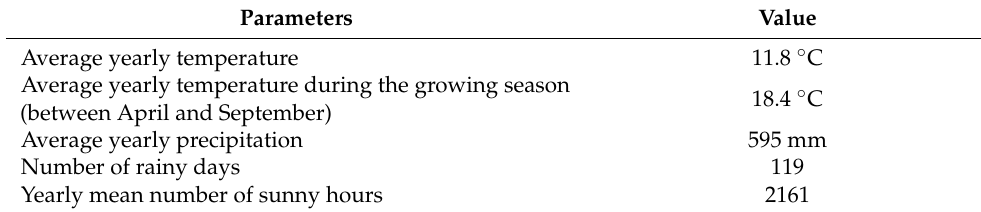
Table 1. Meteorological data during the data collection 2015 – 2018 [39].